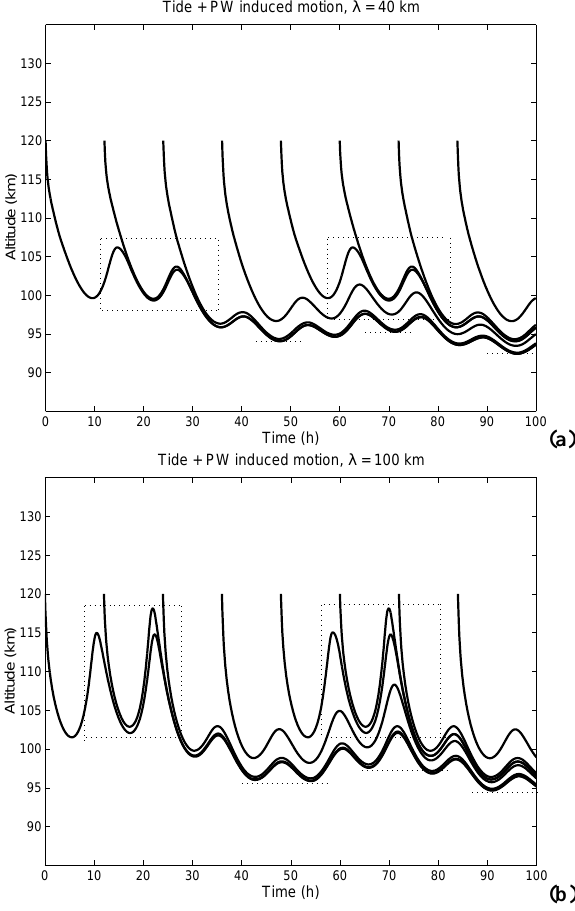
Fig. 5. Ionization motion induced by the linear superposition of a tide with 50m/s amplitude and a PW with 15m/s amplitude during 2 cycles of the long-period wave for two tidal wavelengths: (a) L = 40km; (b) L =